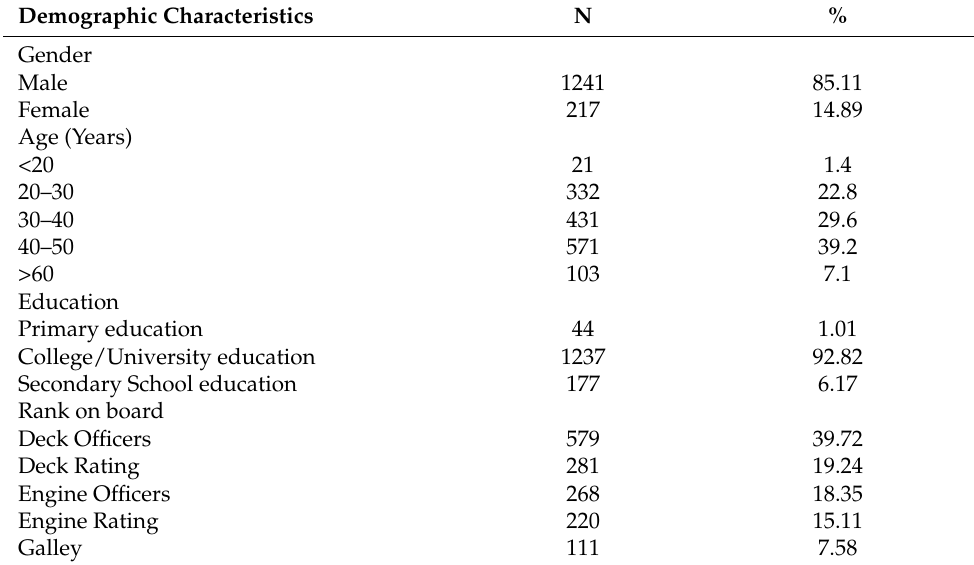
Table 1. Participant demographic and awareness